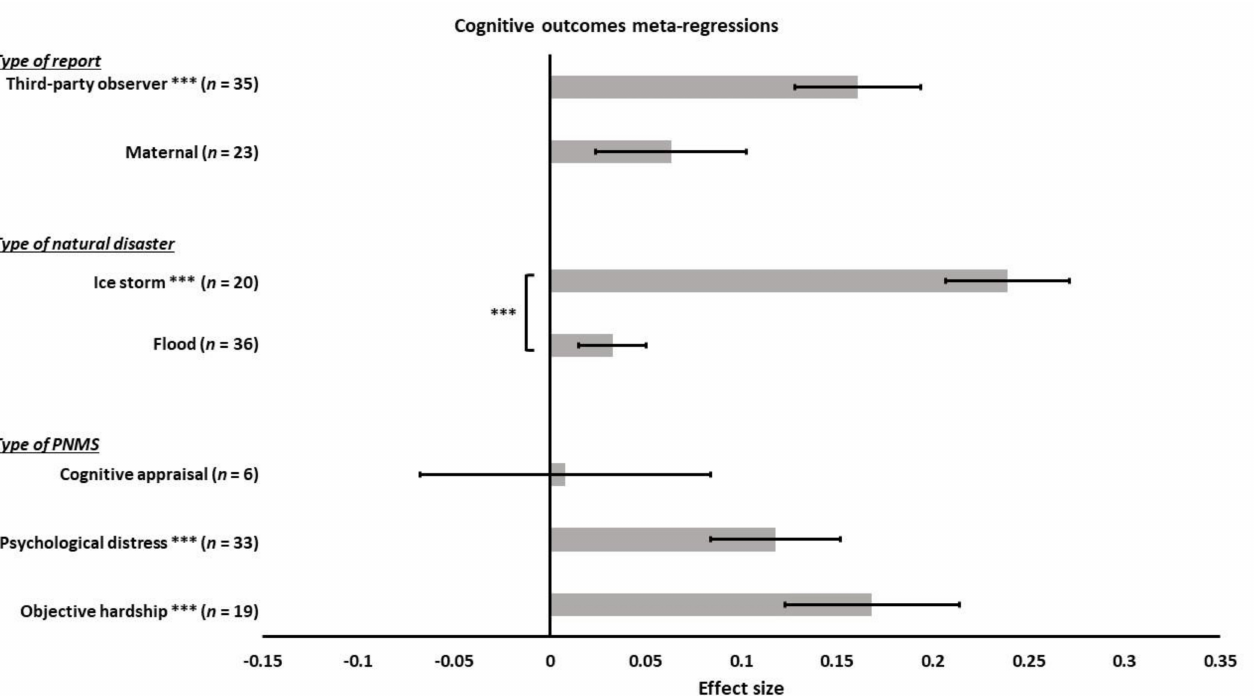
Figure 7. Cognitive outcomes meta-regressions. Type of PNMS effect (objective hardship; psychological distress; cognitive appraisal) on cognitive outcomes, type of natural disaster (flood; ice storm), and type of report (maternal; third-party observer) on the association between PNMS levels and cognitive outcomes. Note: *** p <